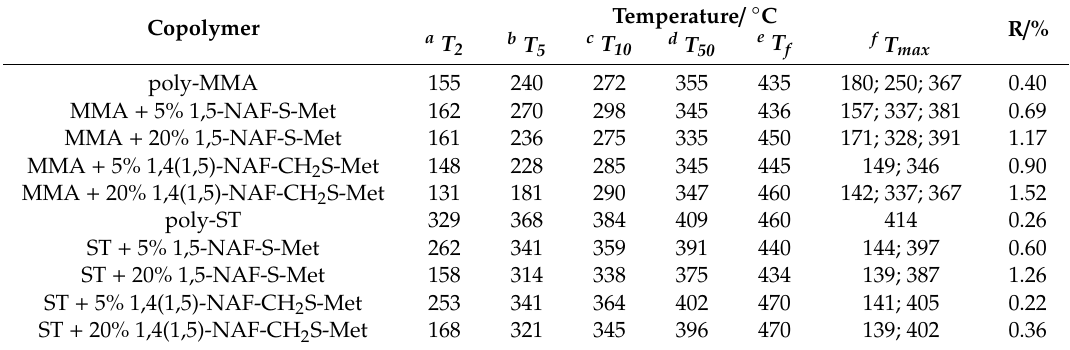
Table 4. Thermal properties of poly-MMA, poly-ST, and obtained